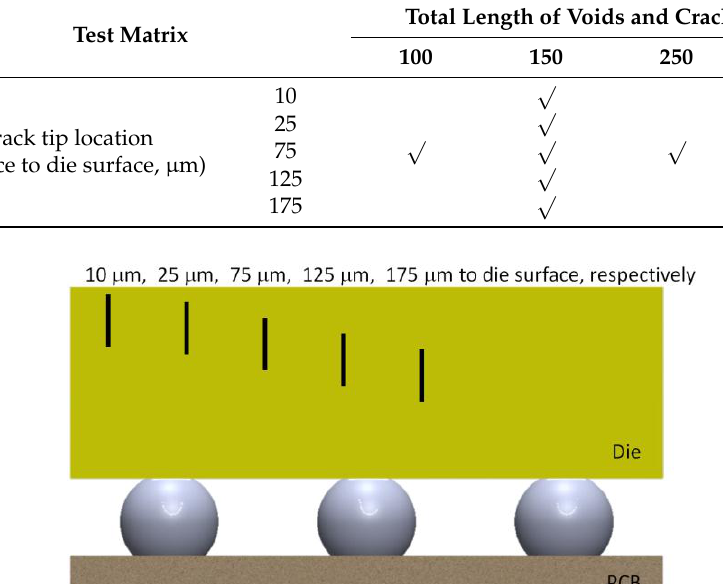
Table 2. Test matrix for studying the effects of crack location and crack length. Test Matrix